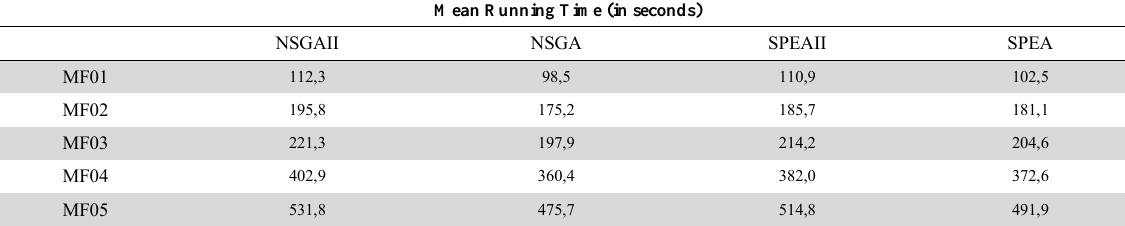
Mean running times of the algorithms. Each algorithm is iterated 30 times Mean Running Time (in seconds) NSGAII NSGA SPEAII SPEA MF01